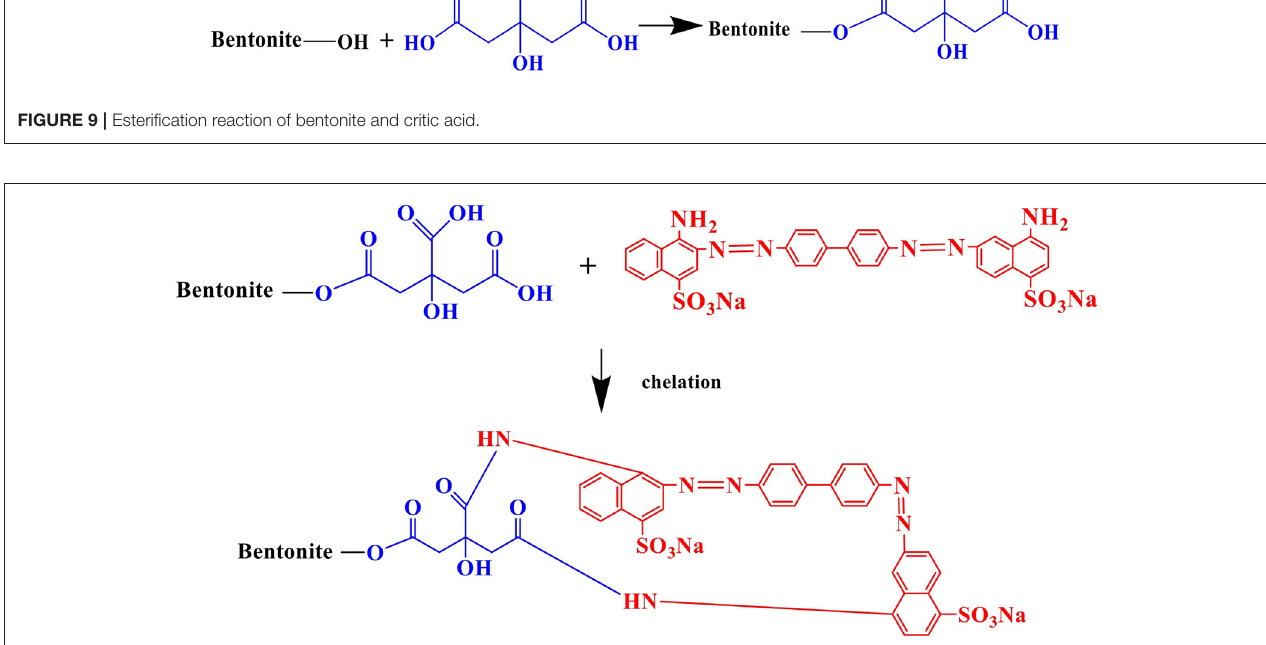
FIGURE 10 | Chelation between CAB and